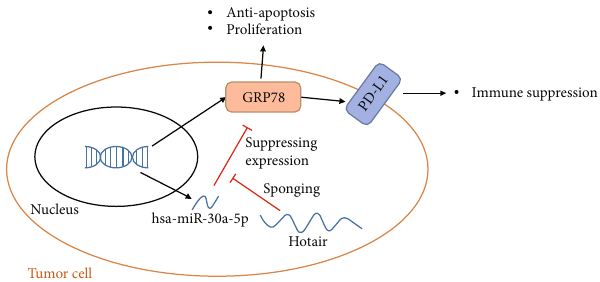
Figure 6: The scheme for the pathway in Hotair/has-miR-30a-5p/ GRP78/PD-L1 in tumor